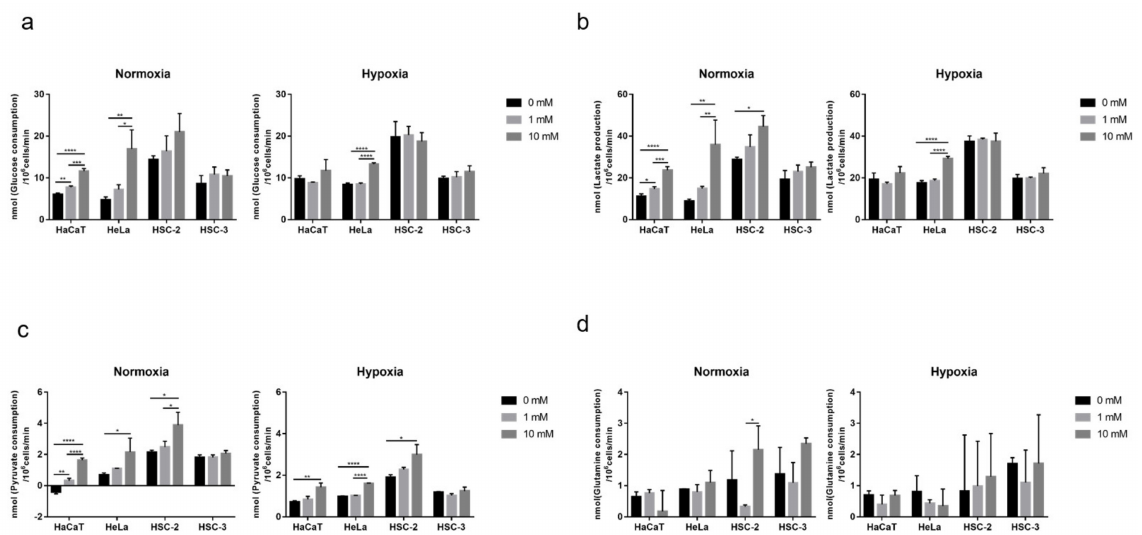
Figure 3. Nutrient consumption during growth with metformin under normoxia and hypoxia. ( a ) Glucose consumption in normoxia ( left ) and hypoxia ( right ). ( b ) Lactate production in normoxia ( left ) and hypoxia ( right ). ( c ) Pyruvate consumption in normoxia ( left ) and hypoxia ( right ). ( d ) Glu- tamine consumption in normoxia ( left ) and hypoxia ( right ). A one-way ANOVA and Tukey’s test. * p < 0.05, ** p < 0.01, *** p < 0.001, **** p < 0.0001. All experiments were independently performed in